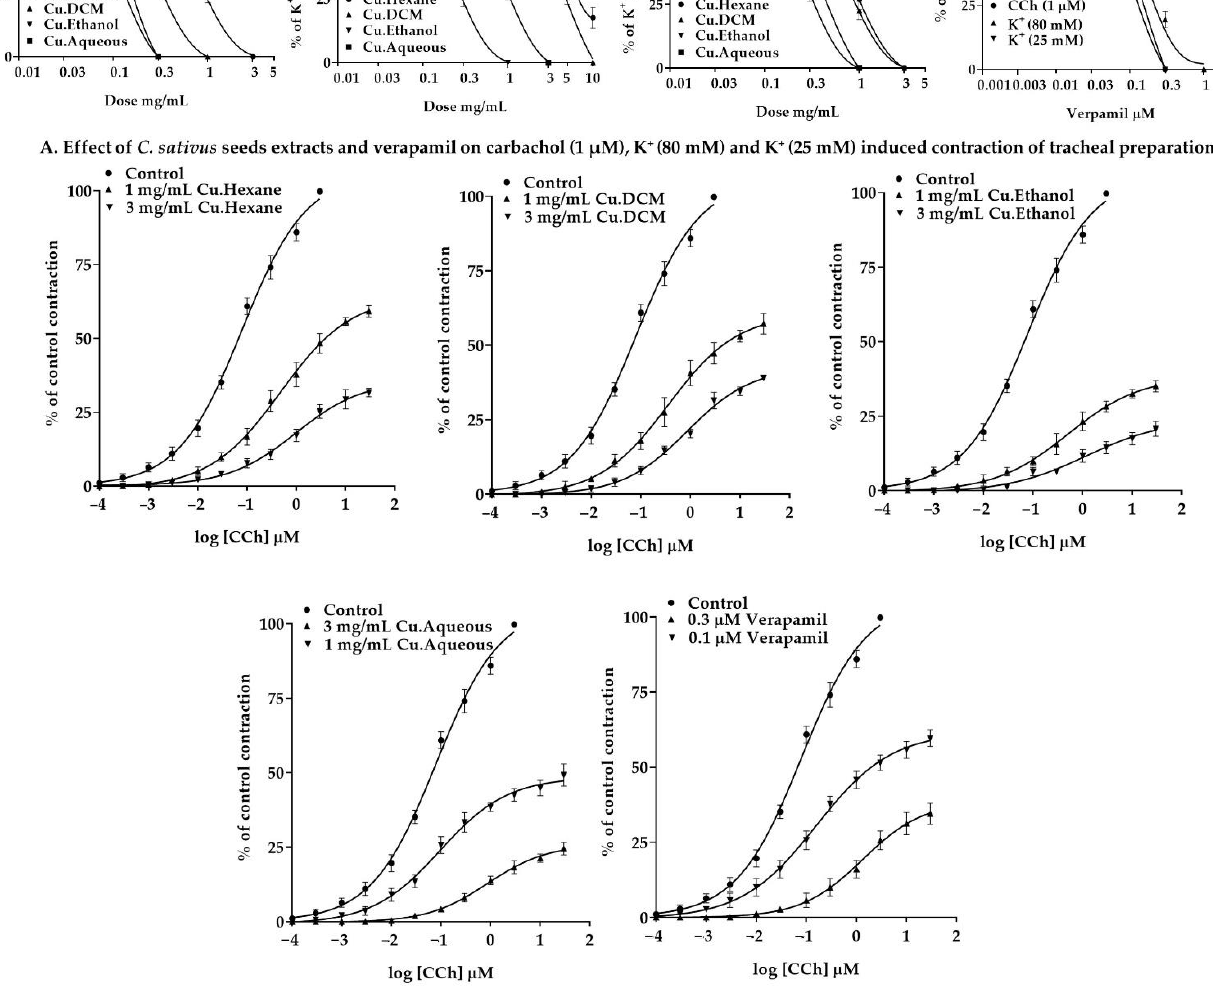
Figure 8. ( A ) Effect of C. sativus seed extracts and verapamil on spastic contractions of K + (80 mM), carbachol (1 µM), and K + (25 mM) in tracheal preparations; ( B ) Carbachol concentration – response curves on tracheal preparation in the presence and absence of C. sativus seed extract and verapamil. Values are expressed as the mean ± SD ( n = 4), and data were evaluated using dose – response curves. Carbachol CRCs were constructed on rabbit tracheal preparations in the presence and absence of C. sativus extracts (1 and 3 mg/mL). These extracts inhibited carbachol CRCs in a noncompetitive rightward shift (Figure 8) . Our results were compared with verapamil, which inhibited the spastic contractions of CCh (1 µ M), K + (80 mM), and K + (25 mM) in a dose-dependent manner, with EC 50 values of 0.1864 µ M (0.1259–0.2945; 95% CI), 0.1212 µ